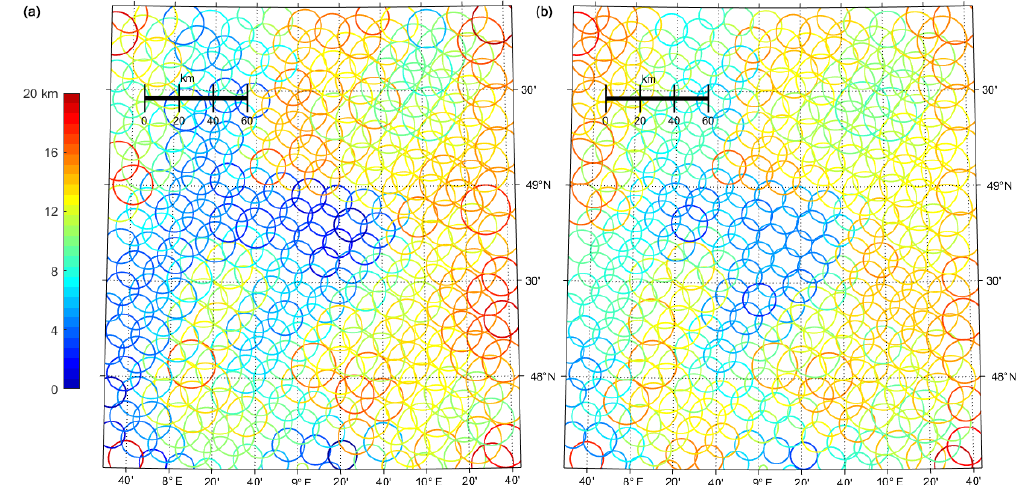
Figure 8. Spatial distribution of the maximum distances of stations (diameter of circles, see scale) for surface-based brightness temperature observations required to keep the sampling error below 10K for H polarization (a) and 5K for V polarization (b) . The color of the circles (see color bar) gives the RMS of the maximum sampling distance over time for the year